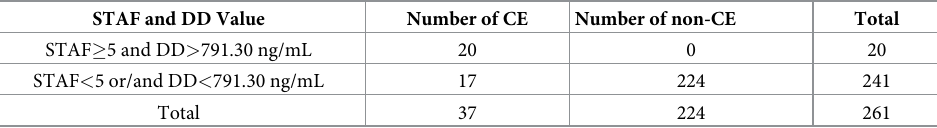
Table 5. Evaluation of STAF and DD in combined diagnosis of CE (series of diagnostic tests).